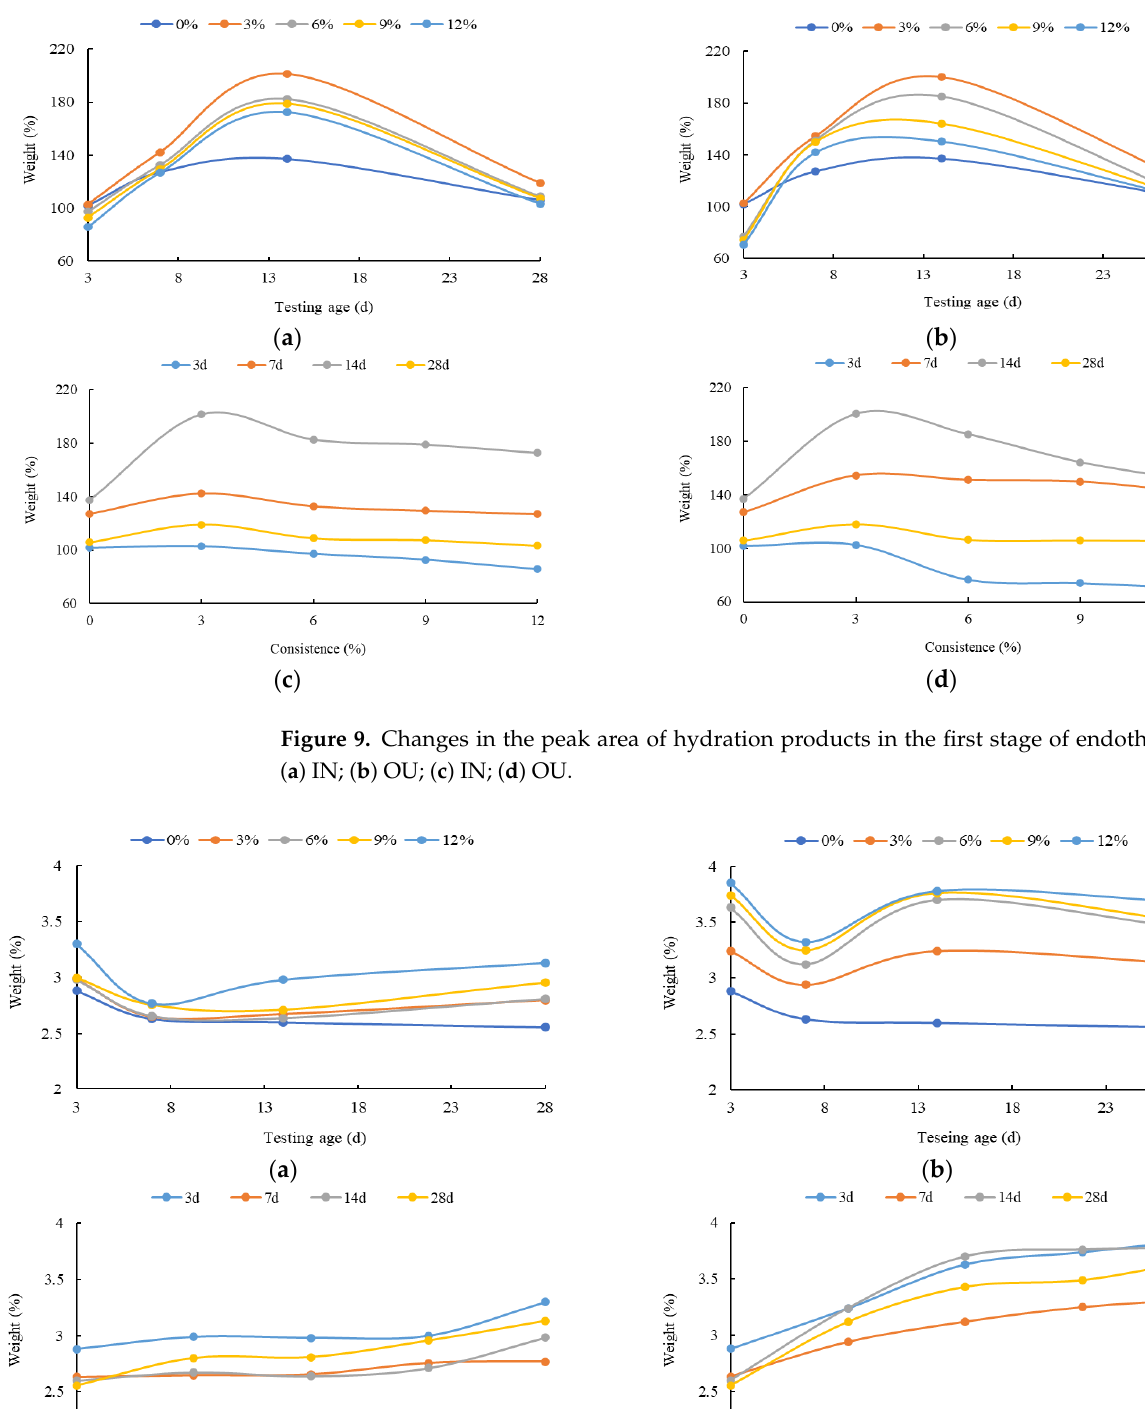
Figure 8. Mass loss rule of hydration products in the first stage of endothermic peak: ( a ) IN; ( b ) OU; ( c ) IN; ( d ) OU